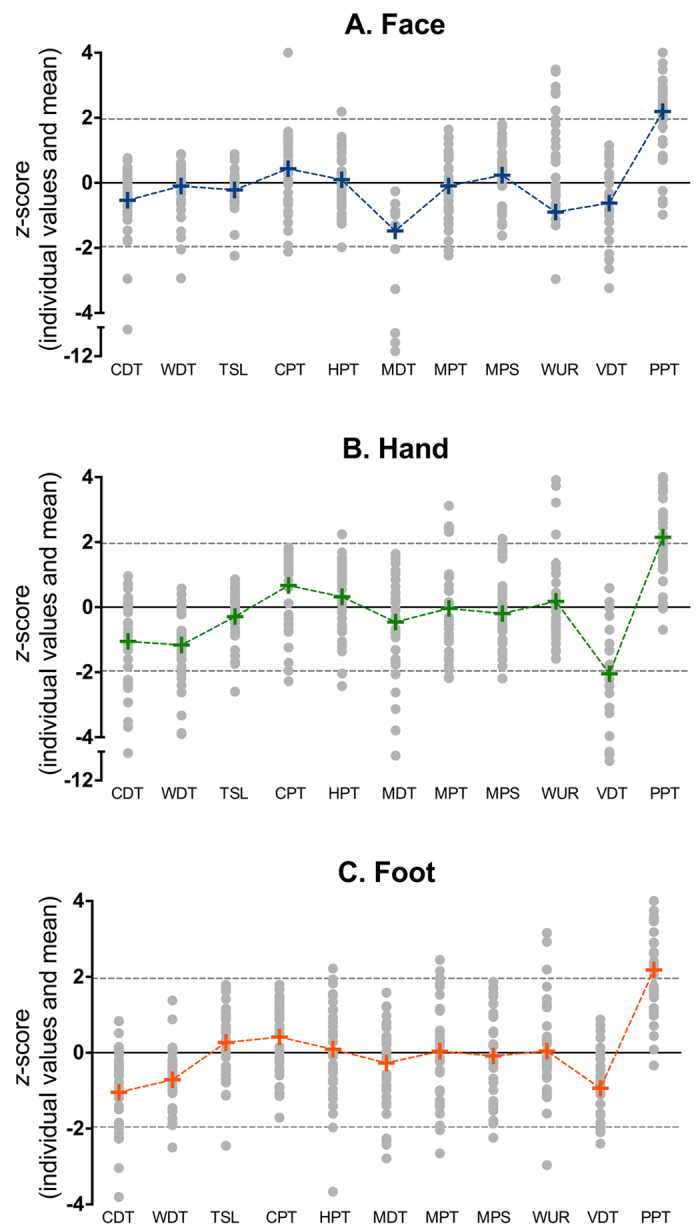
QST profiles of face (A), hand (B) and foot (C) of patients with fibromyalgia. CDT = cold detection threshold; WDT = warm detection threshold; TSL = thermal sensory limen; CPT = cold pain threshold; HPT = heat pain threshold; MDT = mechanical detection threshold; MPT = mechanical pain threshold; MPS = mechanical pain sensitivity; WUR = wind-up ratio; VDT = vibration detection threshold; PPT = pressure pain threshold. The dotted lines indicate ± 1.96*Z above or below which values are considered abnormal. Paradoxical heat sensation and dynamic mechanical allodynia were scored dichotomously and are therefore not included in this figure (see Tables 3 and 4). Each grey dot represents the result observed in one patient. The + signs indicate the mean values.